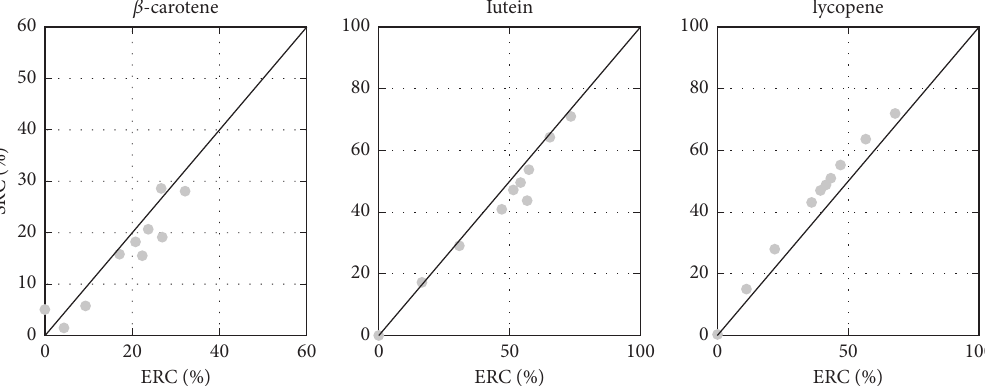
Figure 3: Simulated relative concentrations of individual carotenoid (SRC) obtained by MCRALS compared to experimental relative concentrations